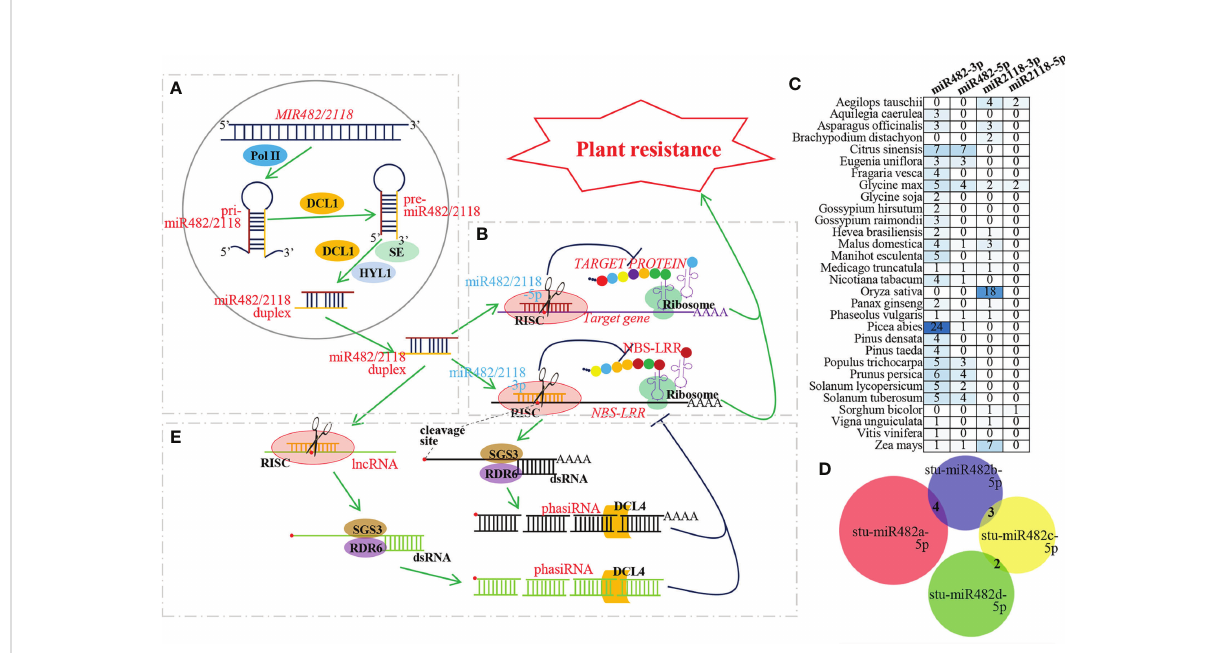
FIGURE 1 Biogenesis and mechanism of miR481/2118 superfamily during plant resistance to pathogen. (A) Biogenesis pathway of miR482/2118. MIR482/ 2118 genes are transcribed by Pol II into pri-miR482/2118. Then, pri-miR482/2118 of hairpin-like structure produces pre-miR482/2118 by DCL1. By DCL1, HYL1 and SE, pre-miR482/2118 is then processed into a miR482/2118-3p/miR482/2118-5p duplex. The mature miR482/2118-3p or miR482/2118-5p liberated from the duplex is commonly incorporated into RISCs to their targets to mediate gene silencing. (B) MiR482/2118-3p and -5p co-regulating plant resistance. MiR482/2118-3p and -5p cleave their target genes to inhibit translation of resistant protein, thus, regulating plant resistance. (C) Quantity variation of miR482/2118-3p and -5p in different plant species. MiRNA resources are downloaded from miRBase database (https://www.mirbase.org/). The numbers in the heat map represent the number of miRNAs. (D) Number of the identical target genes among Solanum tuberosum miR482s (stu-miR482). The target genes are predicted by psRNAtarget (https://www.zhaolab.org/ psRNATarget/) with Expectation ≤ 4. Venn diagram is performed by DeepVenn (http://www.deepvenn.com/). (E) PhasiRNA biogenesis and function during plant resistance to pathogen. 3 ’ fragment of cleaved target gene or lncRNA are converted by RDR6 and SGS3 into double- stranded RNAs, and then they are processed into phasiRNAs through continuous DCL4